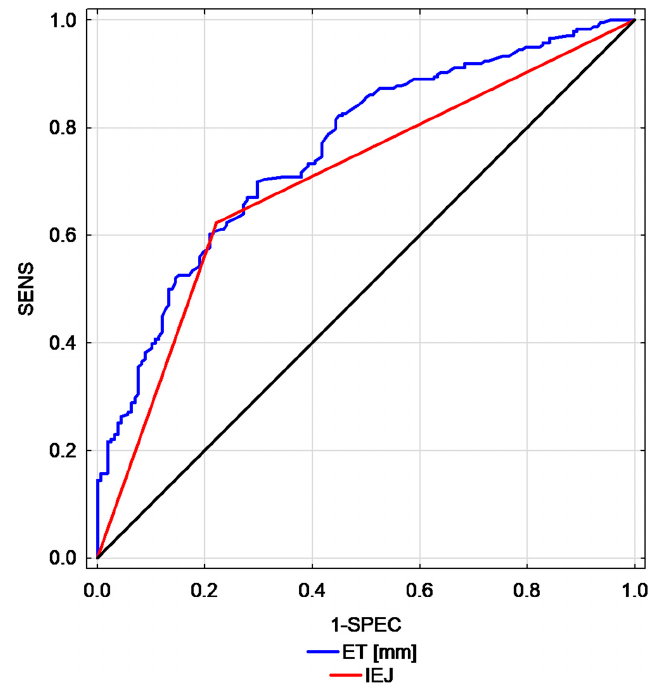
Figure 2. Comparison of receiver operating characteristic (ROC) curves calculated for endometrial thickness versus interrupted endomyometrial junction (endometrial thickness—ET, interrupted endomyometrial junction—IEJ, endometrial thickness—ET, interrupted endometrial junction—IEJ, sensitivity—SENS, specificity—SPEC).